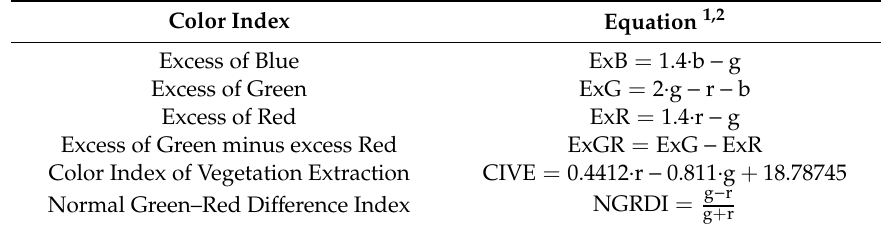
Table 1. Color vegetation